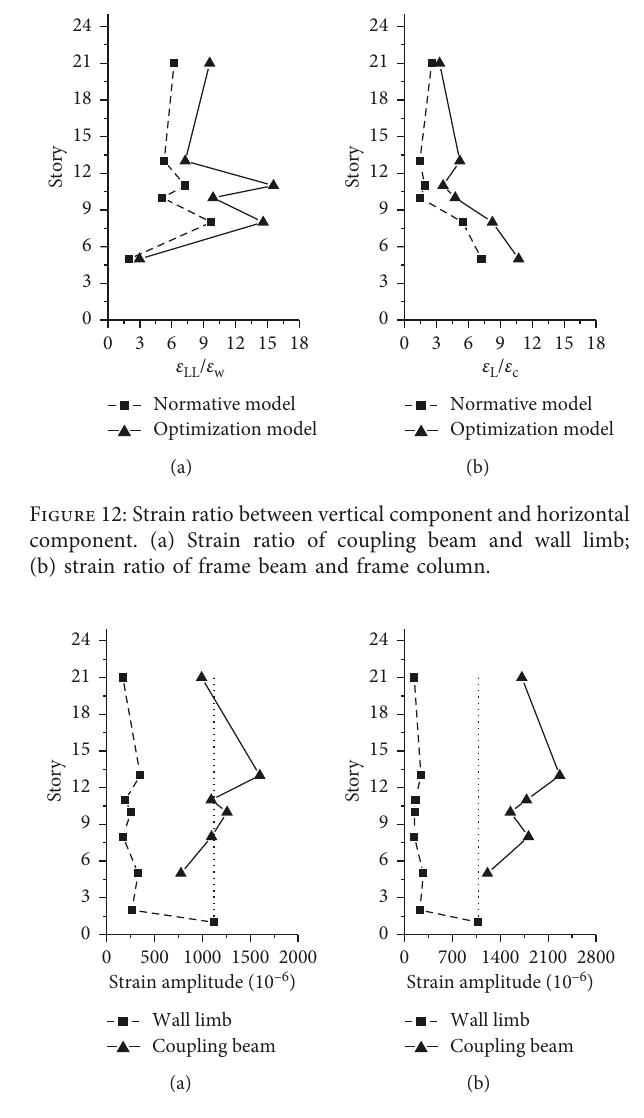
Figure 13: Comparison of strains in coupling beam and wall limb under rare earthquake. (a) Normative model; (b) optimization